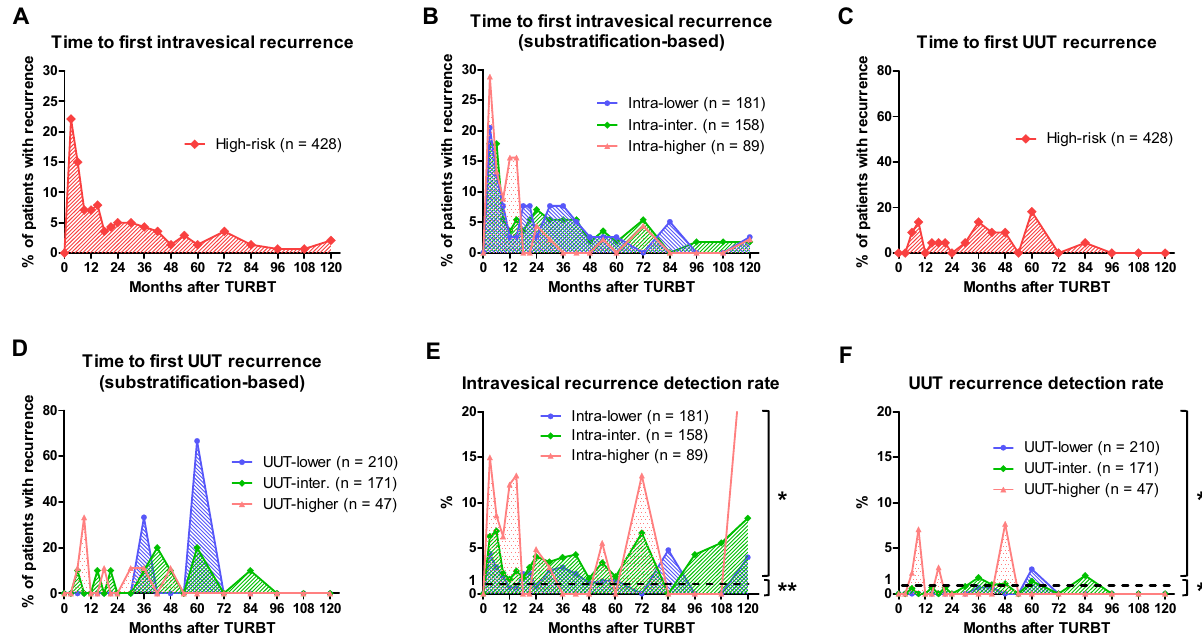
Figure 2. Time courses of recurrence and recurrence detection rates. Time to first intravesical recurrence in all patients with high-risk non-muscle-invasive bladder cancer (NMIBC) ( A ) and in substratified patients ( B ) was evaluated. Time to first upper urinary tract (UUT) recurrence in all patients with high-risk NMIBC ( C ) and in substratified patients ( D ) was evaluated. Intravesical ( E ) and UUT recurrence detection rates ( F ) were evaluated. TURBT, transurethral resection of bladder tumor. *, routine surveillance was needed (≥ 1%). **, routine surveillance was not needed (< 1%).